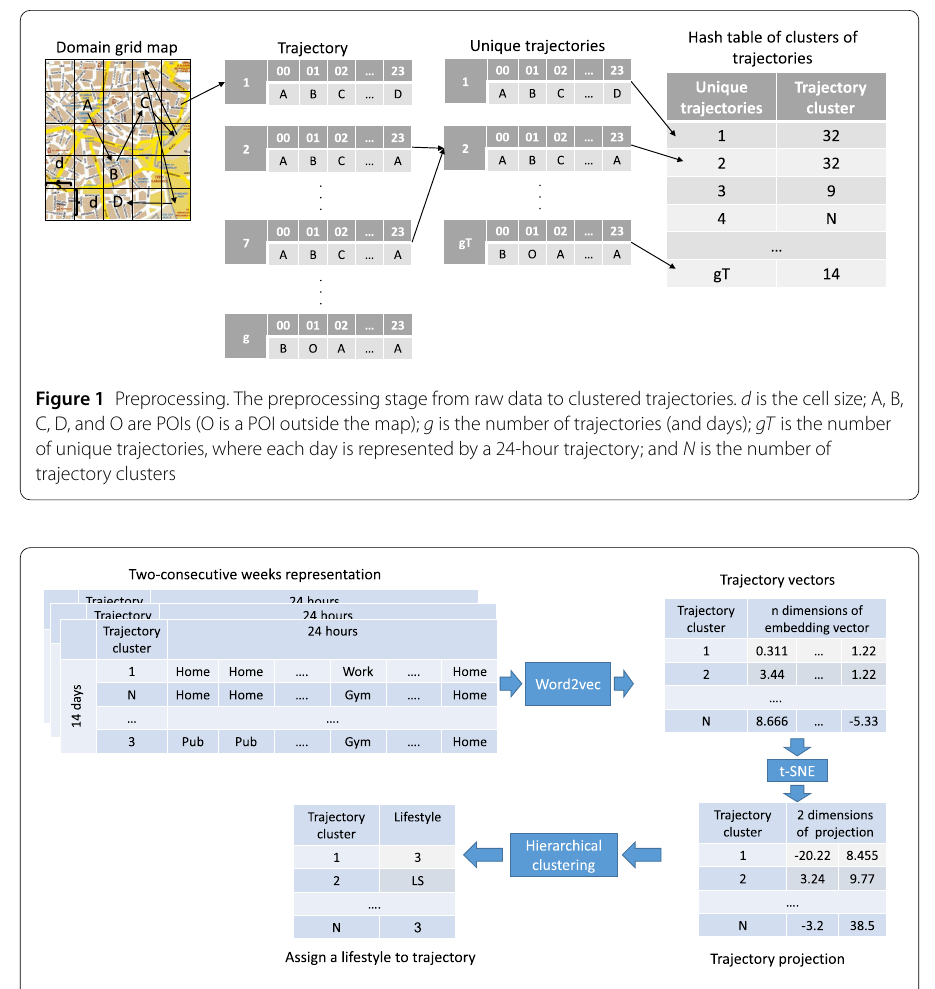
Figure 2 Identifying a lifestyle. The process for identifying a lifestyle to trajectory. N (3000) is the trajectory clusters number, n is the number of the hidden layer in the word2vec model, and LS is the lifestyle